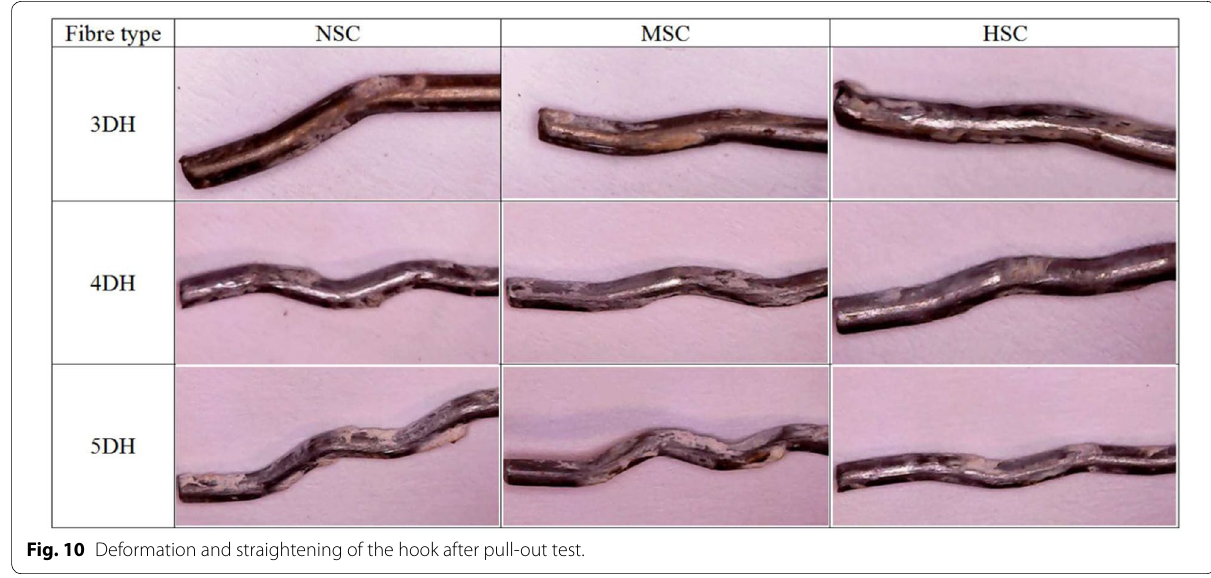
Fig. 10 Deformation and straightening of the hook after pull-out test.